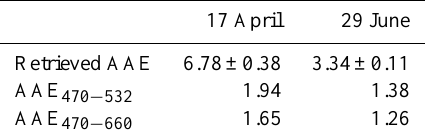
Table 2. Retrieved and in-situ AAE values for 17 April and 29